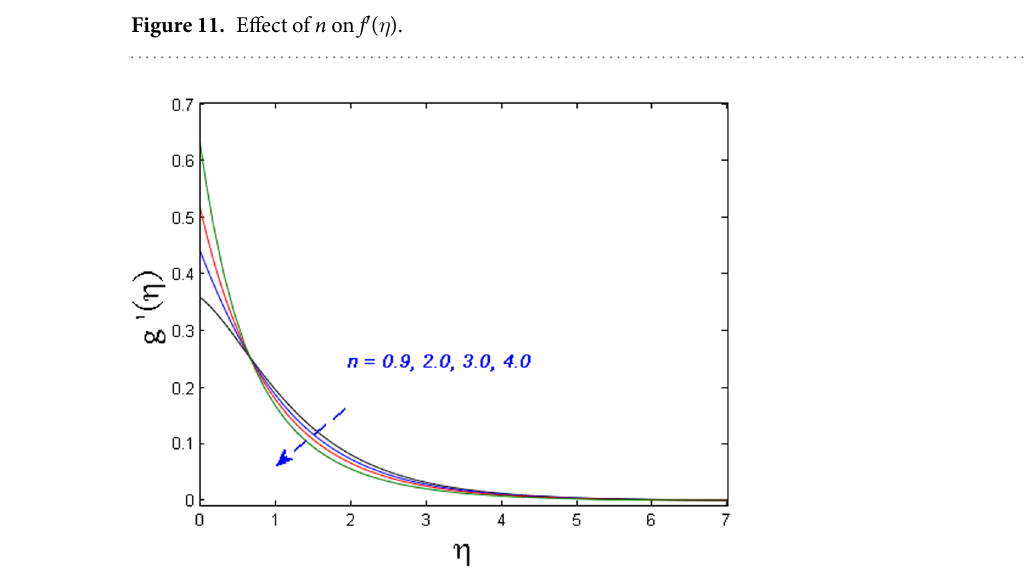
Figure 12. Effect of n on g ′ ( η